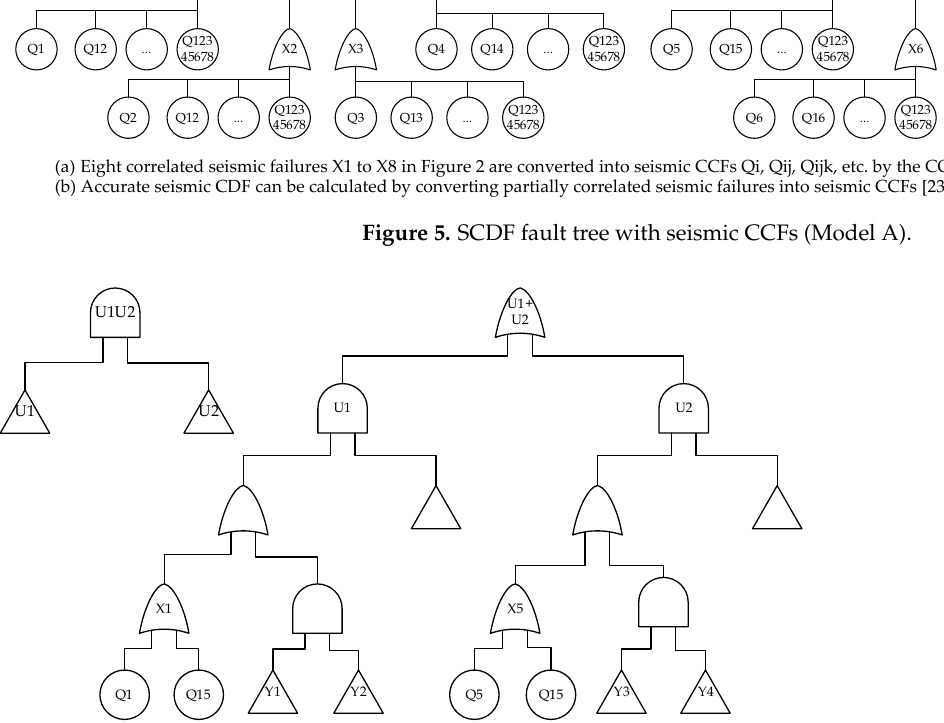
Figure 6. SCDF fault tree with seismic CCFs (Model B).